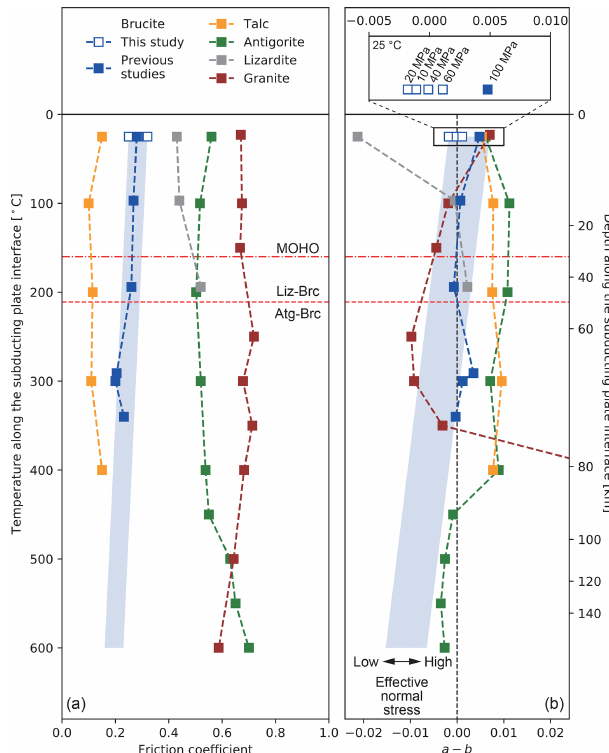
Figure 8. Friction coefficients (a) and velocity dependences (b) of brucite (this study; Moore et al., 2001), talc (Moore and Lock- ner, 2008), antigorite (Okazaki and Katayama, 2015; Takahashi et al., 2011), lizardite (Moore et al., 1997), and granite (Blanpied et al., 1998). The vertical axes are identical to the temperature gra- dient along the subduction plate interface in NE Japan (Peacock and Wang, 1999). The upper dash-dotted line represents the typ- ical depth of the Mohoroviˇci´c discontinuity (MOHO). The lower dashed line represents the phase boundary between lizardite–brucite (Liz–Brc) and antigorite–brucite (Atg–Brc; Peacock and Hyndman, 1999). The blue shaded areas are the estimated frictional character- istics extrapolated from experimental results. With the decrease in the effective normal stress, the a – b value decreases, as indicated by the arrow. This trend was confirmed at room temperature, as shown in the inset at the top of (b) and Fig.